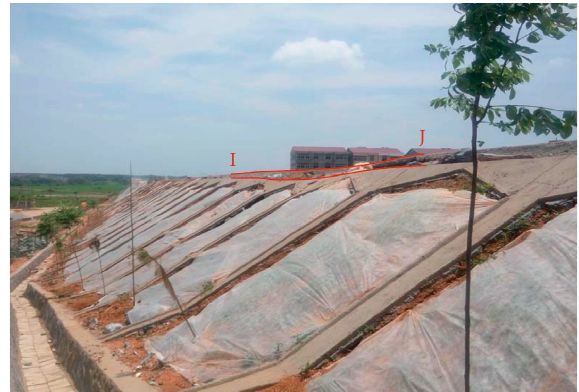
Figure 18: Settlement of the embankment induced by un- derground cave instability.